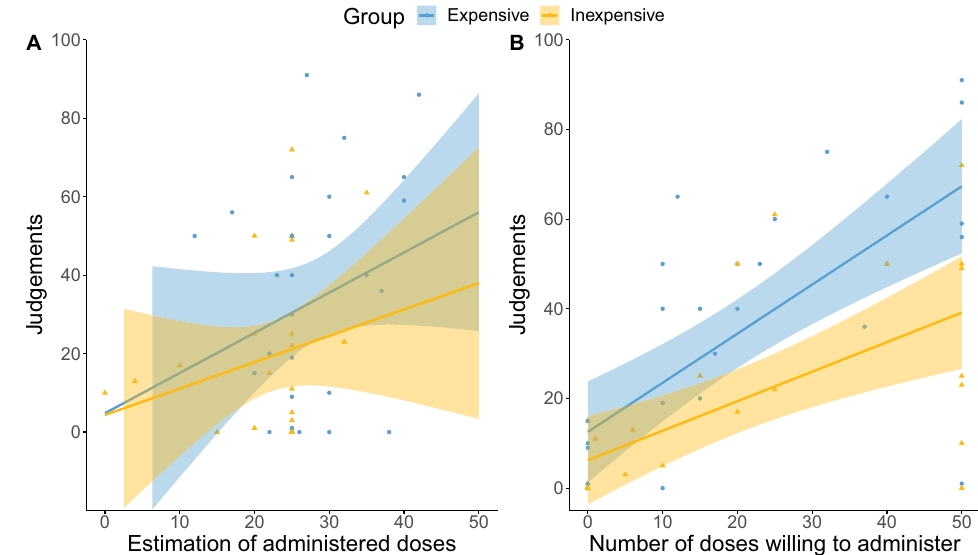
Fig. 3 Scatterplots of the relationship between judgements and the estimation of A administered doses, and B the number of doses willing to administer. Note. Colours split experimental groups: yellow represents the inexpensive groups’ responses, and blue represents the expensive group. Dots and triangles depict each participant’s data, while the lines show the regression lines with 95% confidence